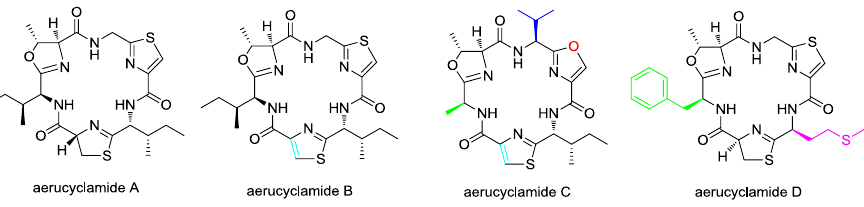
Figure 4. Structures of aerucyclamides A–D.